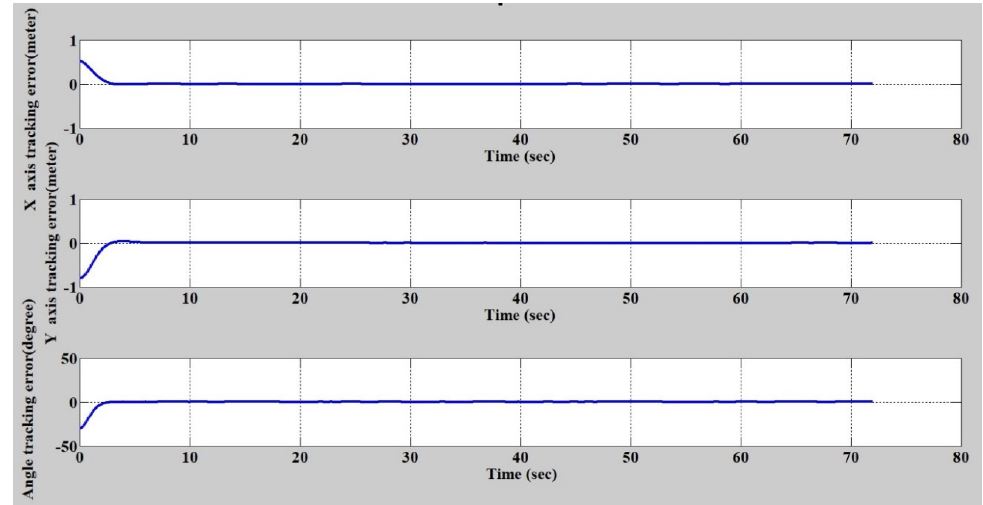
Figure 2. Circular trajectory tracking result of H 2 proposed control design with respect to four different initial conditions: ( x c = 1.9 m, y c = 0 m, blue line), ( x c = − 1.9 m, y c = 0 m, red line), ( x c = 0 m, y c =